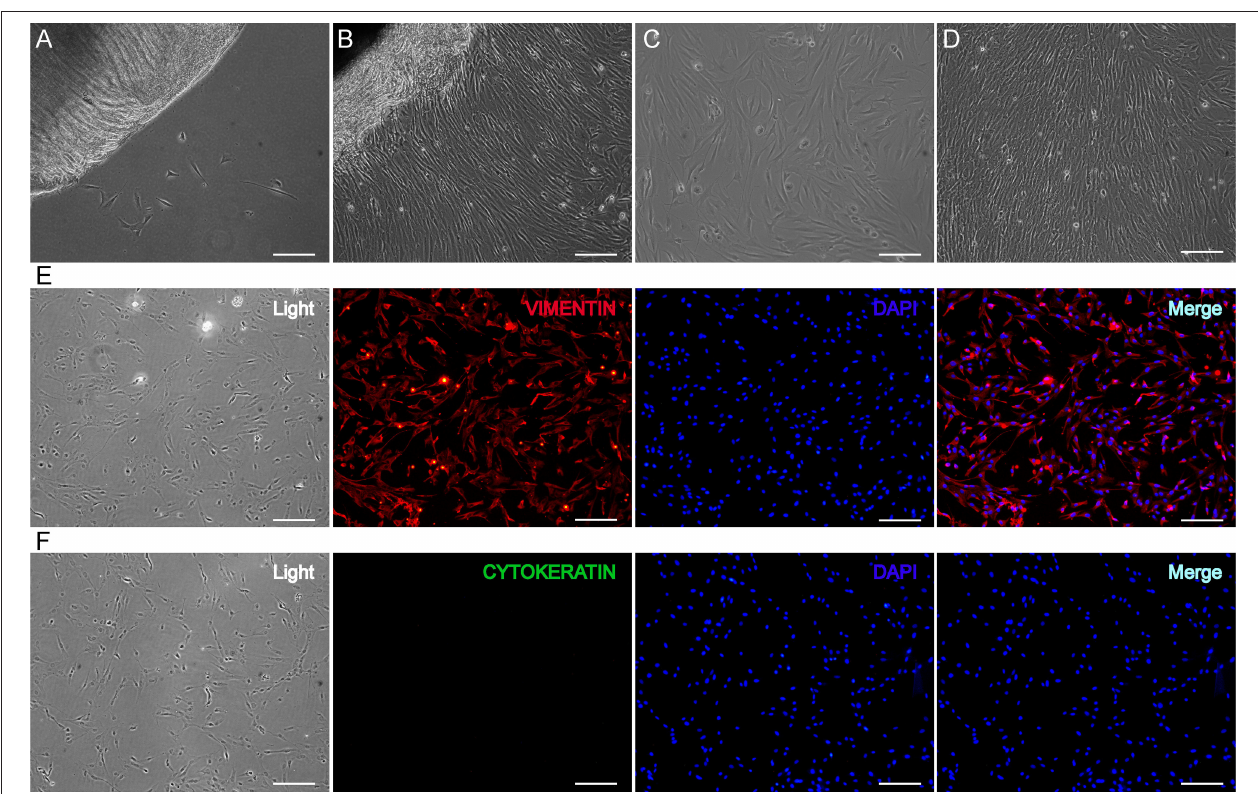
FIGURE 1 | Isolation and identification of GEFs. GEFs were isolated from 30-day gestational goat fetuses by tissue block attachment method. The migration of the cells was observed under an inverted microscope after 3 days (A) and 9 days (B) of adhesion. The cells that migrated from the tissue blocks were digested and collected, and the cell suspensions were re-inoculated into new petri dishes. The cell status was observed under an inverted microscope on the 2nd day (C) and 4th day (D) after subculture. Third-generation GEFs were used for cell immunofluorescence staining. After culture for 2 days, the attached GEFs were subjected to fluorescent immunocytochemistry using anti-vimentin (red, E ) and anti-cytokeratin (green, F ) antibodies. Scale bar, 50 µ m. GEFs, goat embryonic